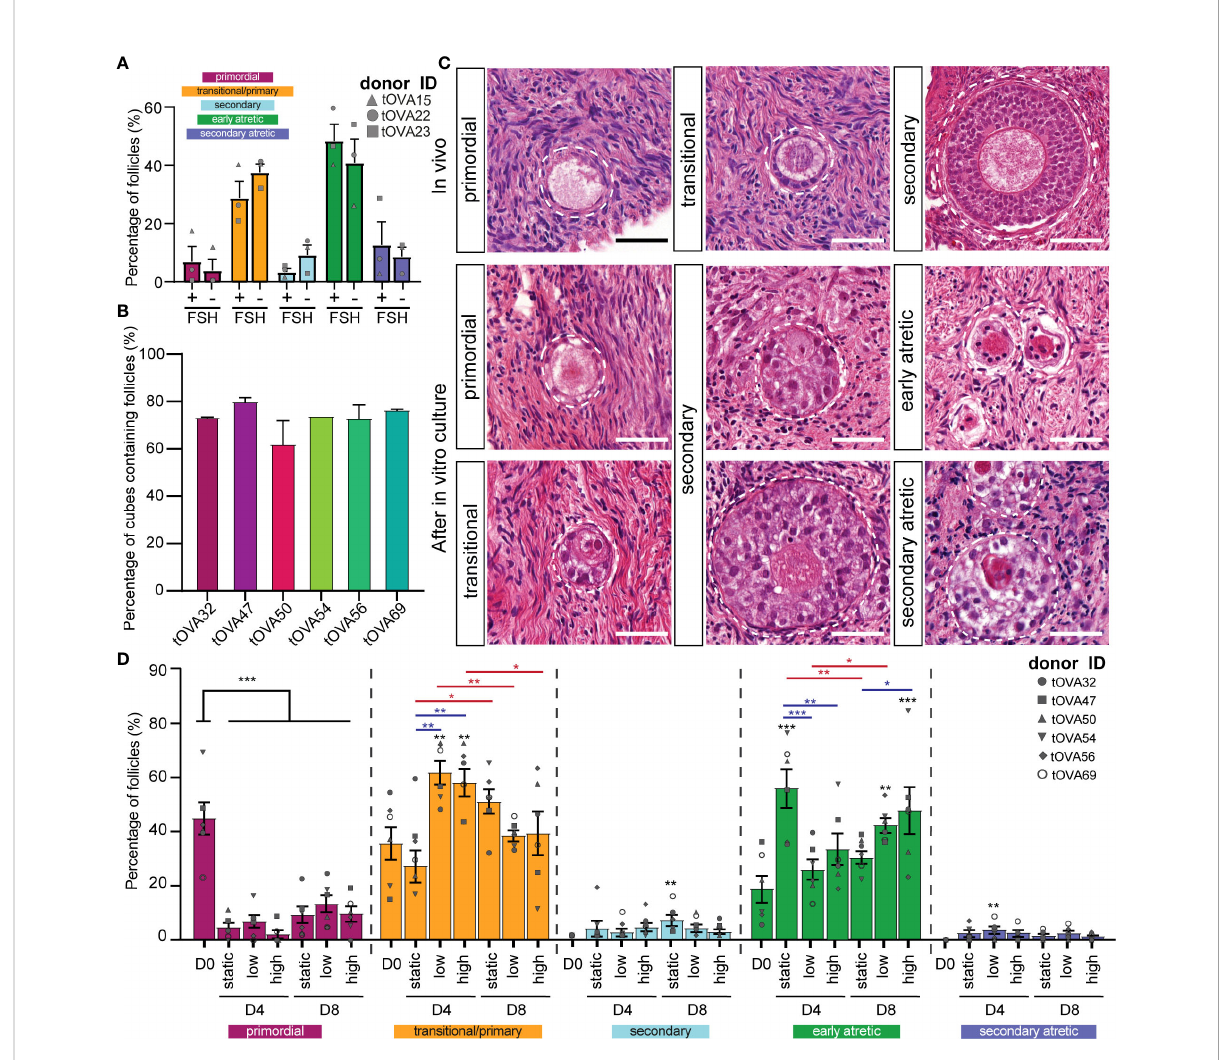
FIGURE 3 Distribution of follicles in ovarian cortical cubes after in vitro culture. (A) Distribution of follicular stages after eight days in culture with or without 1ng/ml of FSH. Results depict the percentage of each follicular stage per condition (mean ± SEM) compared per follicular stage. A total of N=120 cortical tissue cubes containing in total 321 follicles were classi fi ed. Statistical analysis was performed using Shapiro-Wilk test for normal distribution followed by multiple t-test. *=p_value < 0.05; ** = p_value < 0.01; ***=p_value <0.001. (B) Percentage of cortical tissue cubes containing follicles per donor (mean ± SEM). (C) Follicular classi fi cation used in this study. Top row shows in vivo control ovarian follicles in histological sections from freshly-isolated transmasculine donors. Bottom rows show in vitro cultured ovarian follicles. Scale bars = 40 m m. (D) Distribution of follicular stages after D4 and D8 in static, dynamic low and dynamic high culture. Results depict the percentage of each follicular stage per condition (mean ± SEM) compared per follicular stage. A total of N=497 cortical tissue cubes containing in total